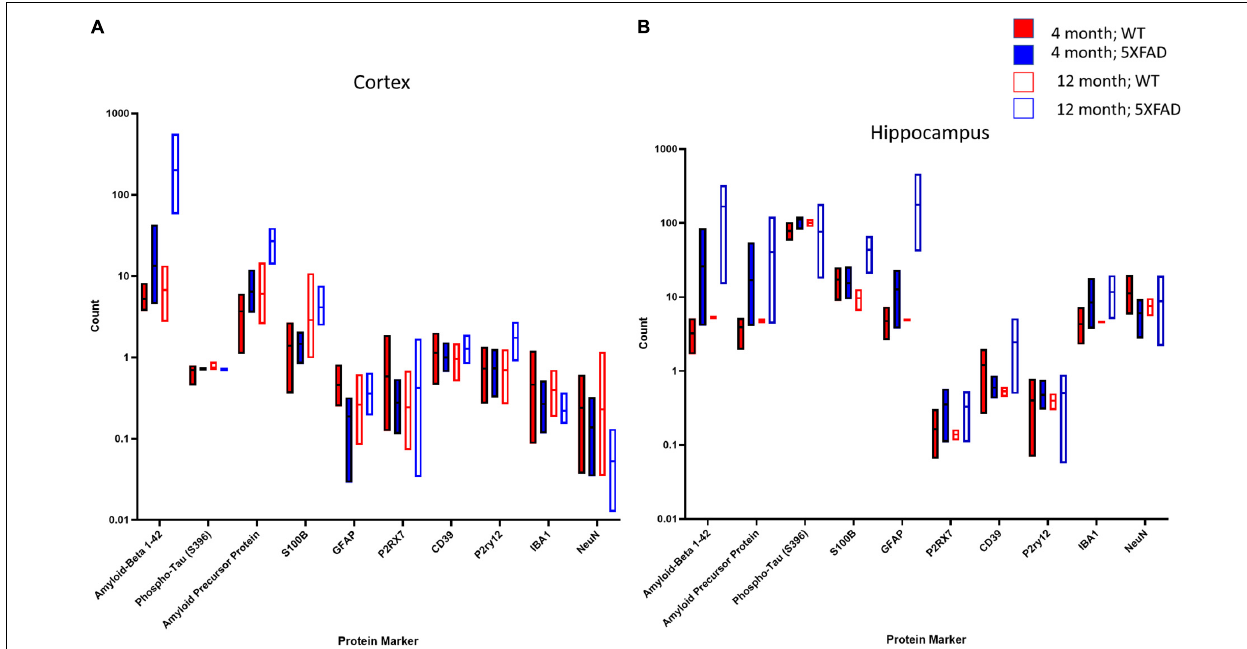
FIGURE 8 | NanoString GeoMX system indicates protein changes in cortex and hippocampus in 5XFAD mice compared to controls at 4 and 12 months. In the cortex (A) , several protein markers were upregulated in the 5XFAD mouse compared to controls at both time points. The greatest increases in the cortex were in A ββ 1–42 and APP, while reductions were observed in NeuN by 12 months of age. In the hippocampus (B) , markers related to AD pathology (A ββ 1–42, APP) as well as inflammation were upregulated as early as 4 months of